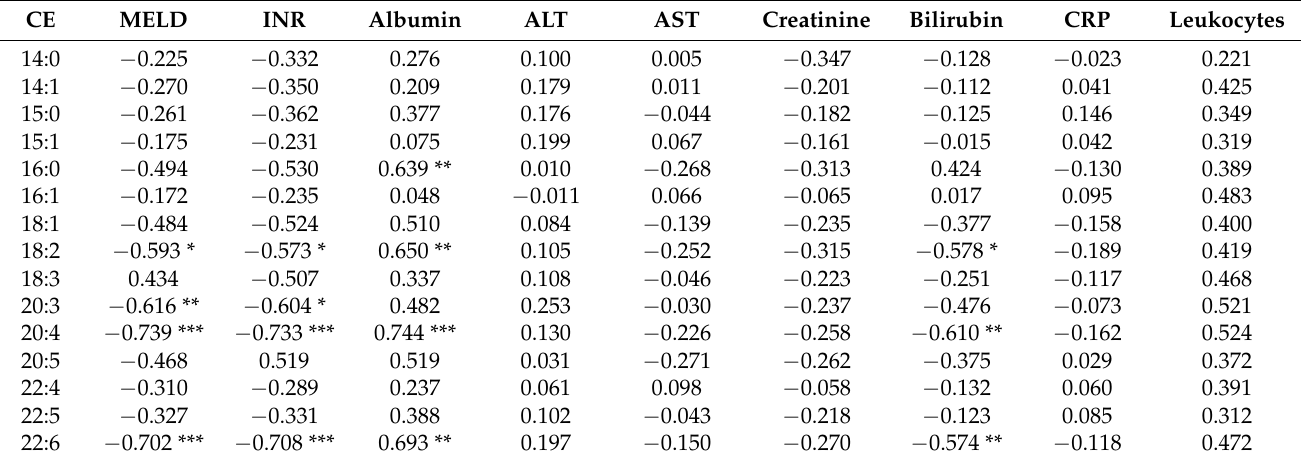
Table 2. Spearman correlation coefficients of CE species with the MELD score as well as laboratory measures of patients without diabetes and with liver cirrhosis before therapy. * p < 0.05, ** p <